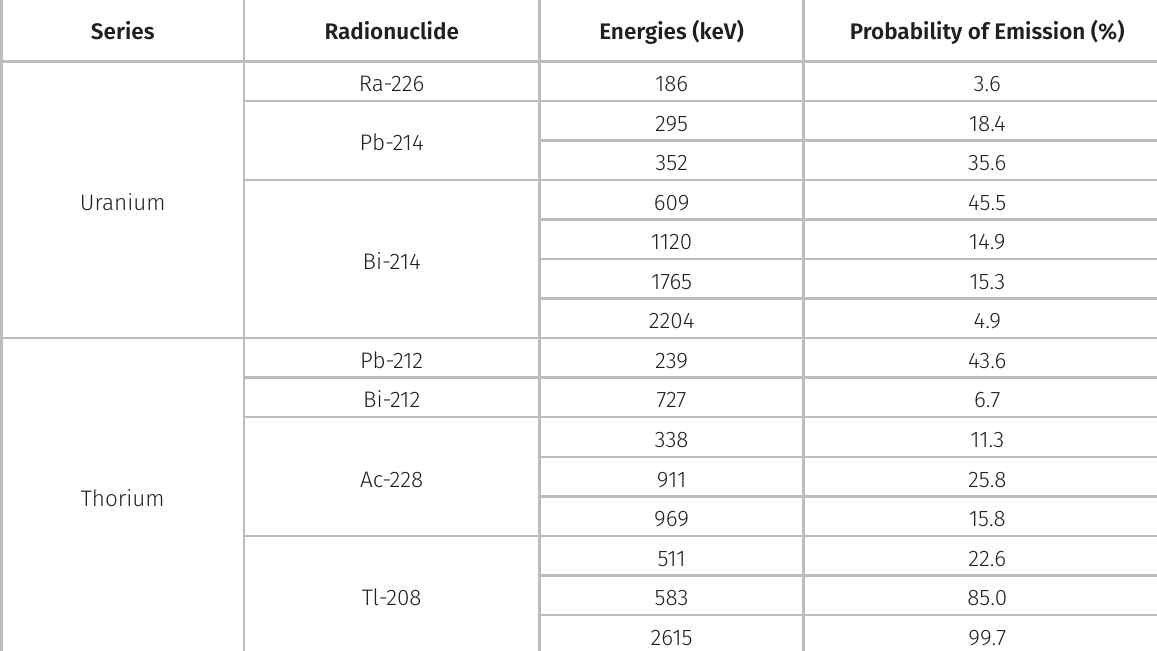
Table II. Energies used in computational